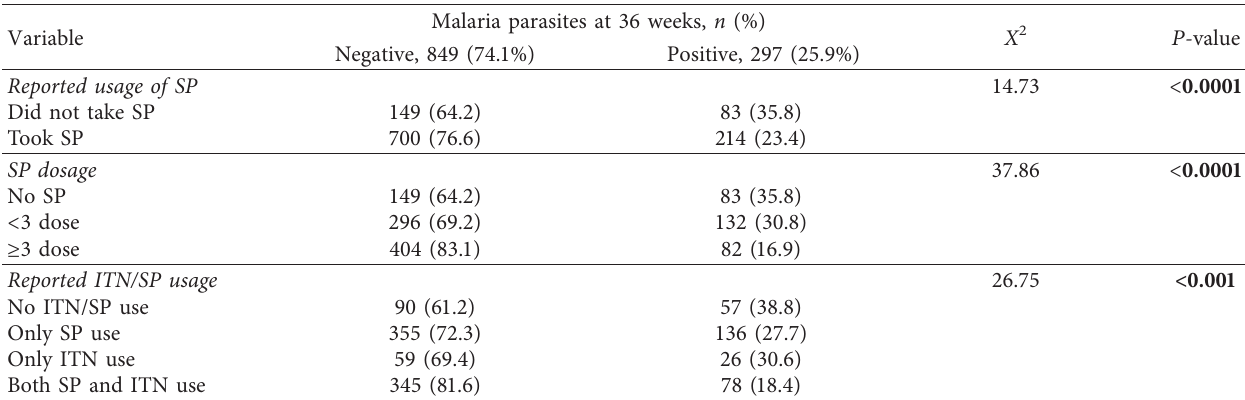
Figure 1: Reported usage of SP among the study respondents. Table 3: Prevalence of malaria at 36 weeks of gestation.